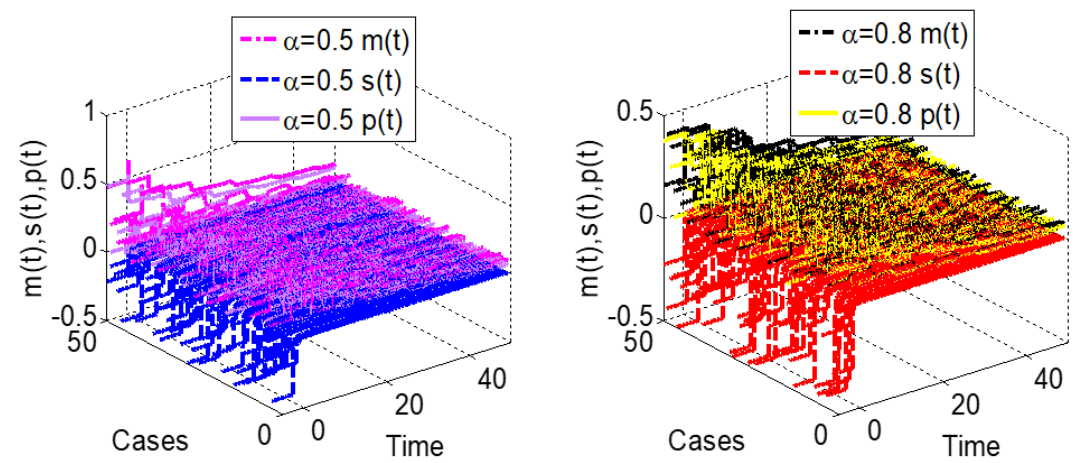
Figure 11. Time response of the three-dimension FOGRN when τ =